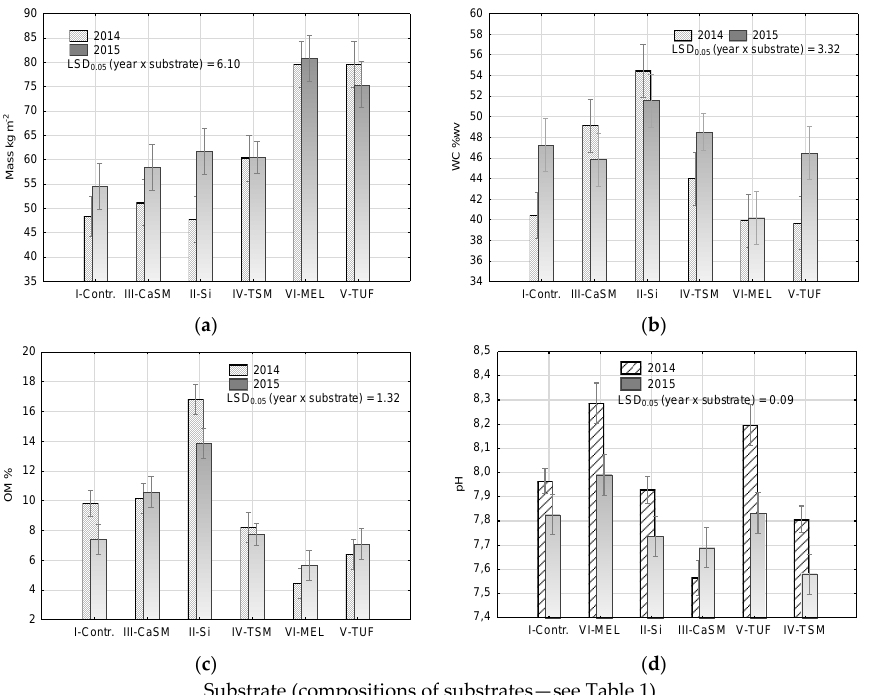
Figure 2. Selected physical parameters ( a , b , d ) and organic matter ( c ) content (%) of six different green roof substrates during the two years of the Sedum acre L. experiment.